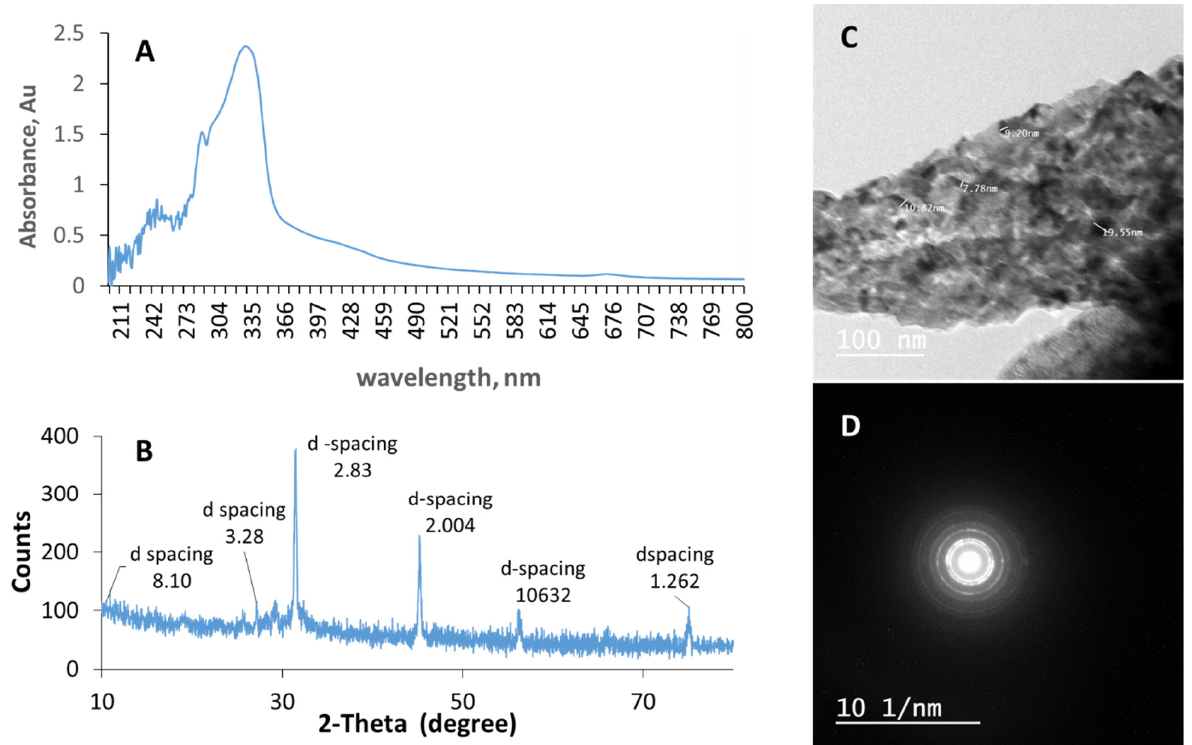
Figure 2. ( A ) UV-vis spectrum, ( B ) XRD pattern, ( C ) TEM image, and ( D ) ring diffraction patterns for the copper nanoparticles.